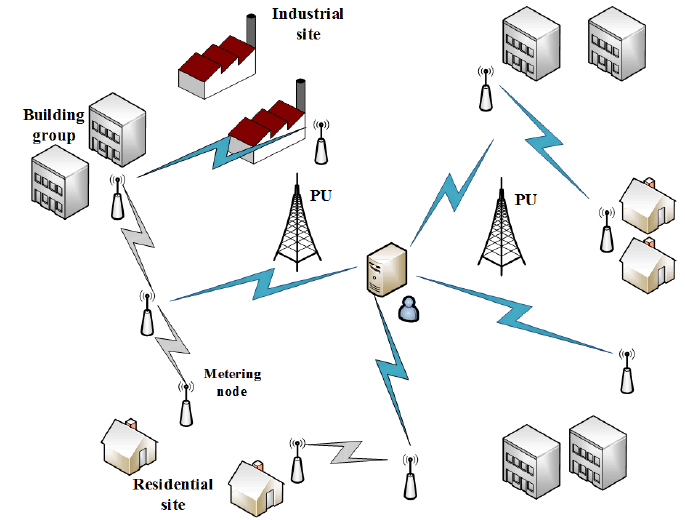
Figure 1. The schematic of AMI